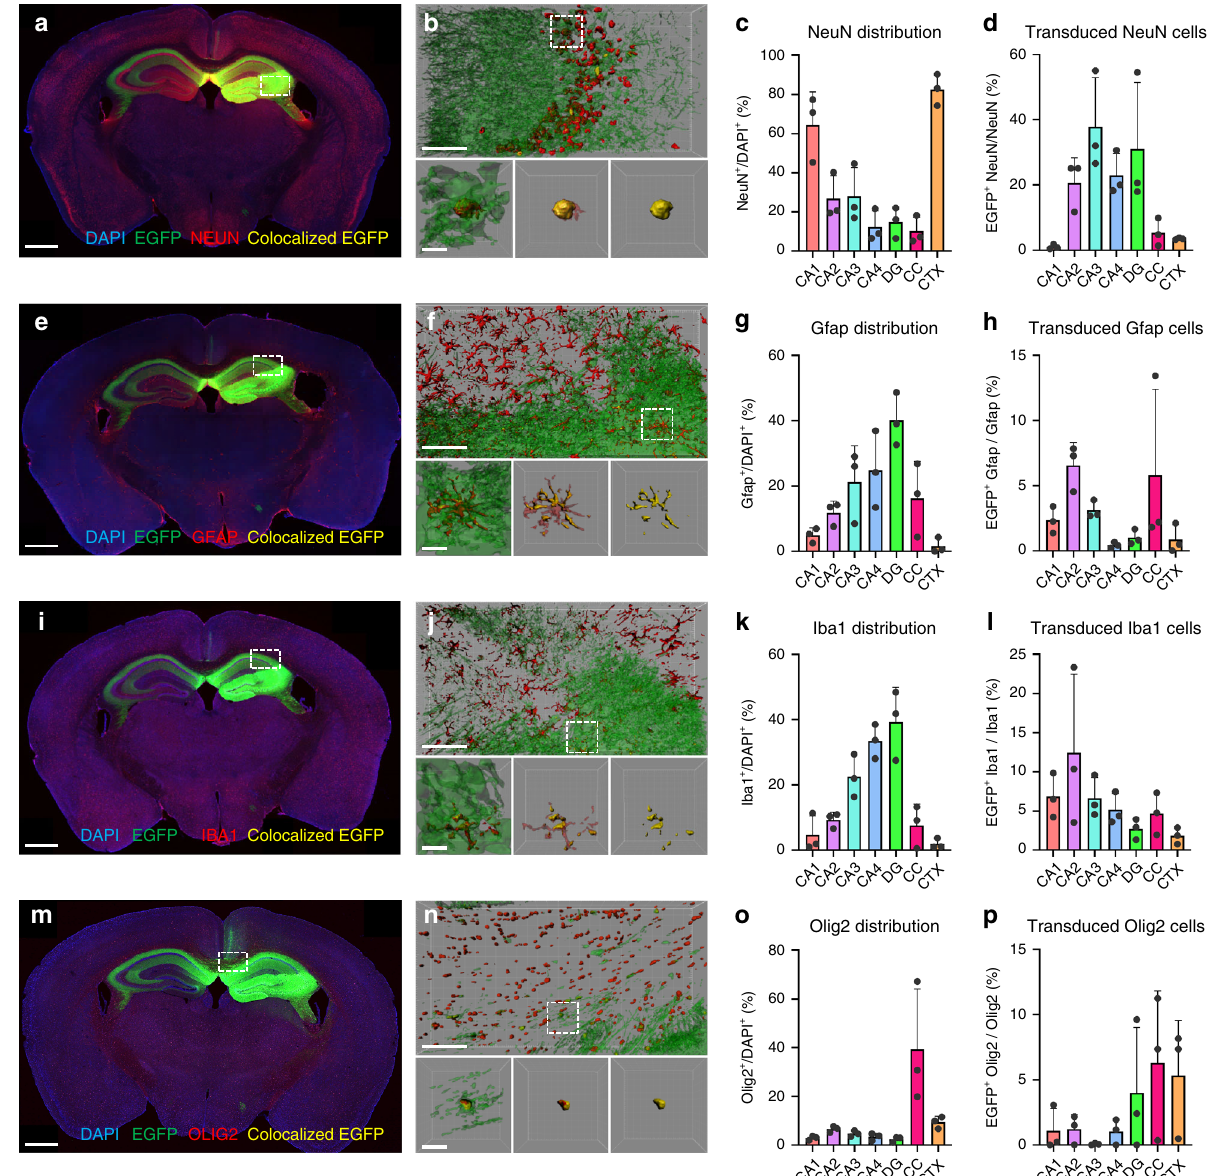
Fig. 3 Transduction of major cell types of the brain by rAAVv66. a , e , i , m Coronal sections of rAAVv66- CB6-PI-EGFP transduced mouse brains. IF- stained sections (red) with antibodies against NEUN ( a, neurons), GFAP ( e , astrocytes), IBA1 ( i , microglia), or OLIG2 ( m , oligodendrocytes) indicate the distribution of cell types across the brain. Native EGFP expression (green) that colocalize with IF staining (yellow) reveal the positively transduced cell type indicated. Scale bars = 700 μ m. b , f , j , n 3D rendering of sub-anatomical regions of single representative frames from dashed line rectangle boxes within coronal section views (top panels) with single-cell representations from fi elds de fi ned by dashed lined square boxes (bottom three panels). Left panels, total area EGFP and cell marker IF stains; center panels, colocalized EGFP with total cell marker IF stains; right panels, colocalized EGFP and cell marker IF stains. Scale bars = 50 μ m (top panels), 5 μ m (bottom three panels). c , g , k , o Quanti fi cation of cell type-speci fi c IF staining across indicated hippocampal regions ( x -axes), normalized to DAPI signal. d , h , l , p Quanti fi cation of cell type-speci fi c transduction across indicated regions, normalized to total cell-type IF and DAPI signal. Data are presented as the mean ± SD, n = 3 animals/group from one experiment. Cornu ammonis (CA1 – CA4), dentate gyrus (DG), corpus callosum (CC), and cortex